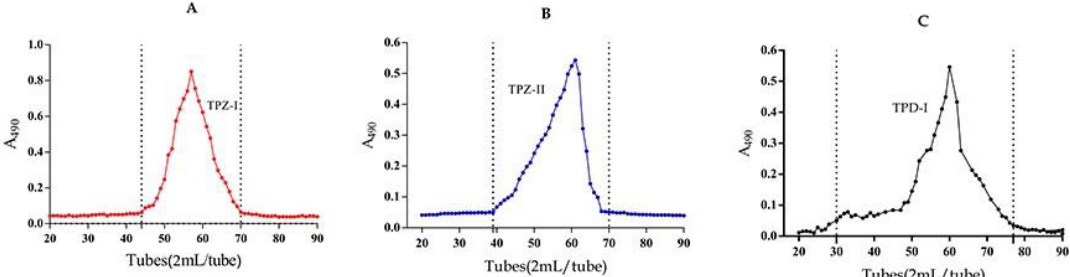
Figure 2. The carbohydrate elution profiles of gel filtration chromatography, monitored with the phenol-sulfuric acid assay. Elution profiles of ( A ) TPZ-I, ( B ) TPZ-II, and ( C ) TPD-I.